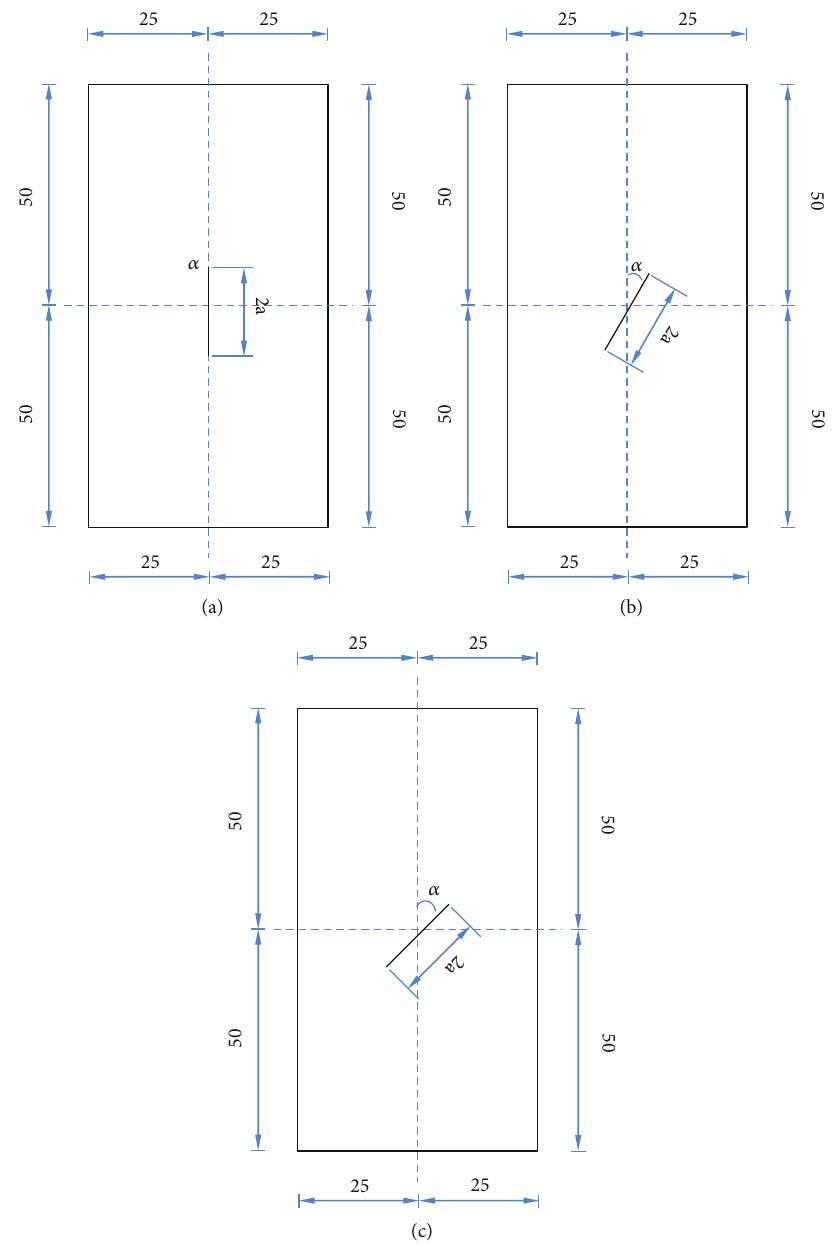
Figure 1: Prefabricated fi ssured specimen with di ff erent inclinations: (a) specimen with α = 0 ° , (b) specimen with α = 30 ° , and (c) specimen with α = 45 ° , 2a = 20